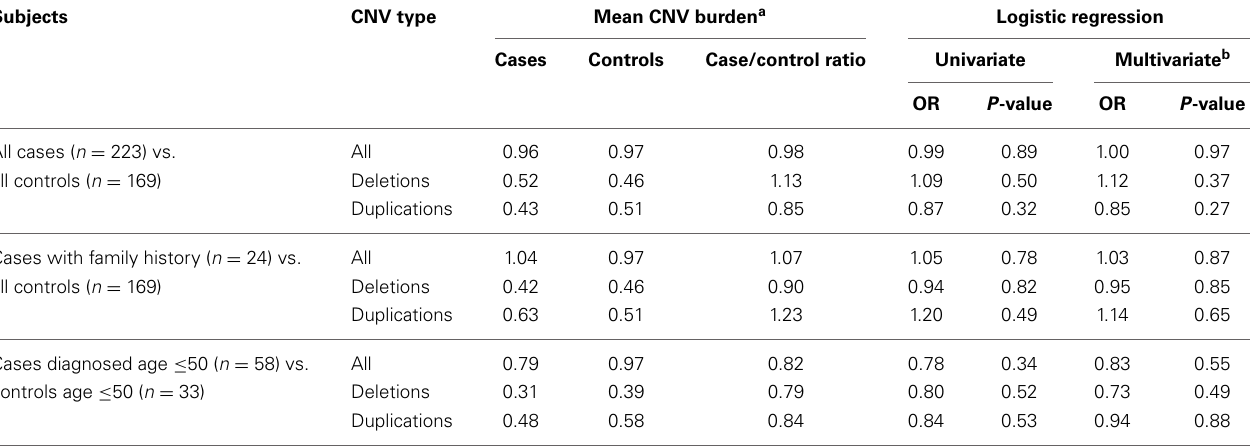
Table 4 | Comparison of putative rare or de novo CNV burden in cases and controls based on a subset of 377 CNV calls observed in a single